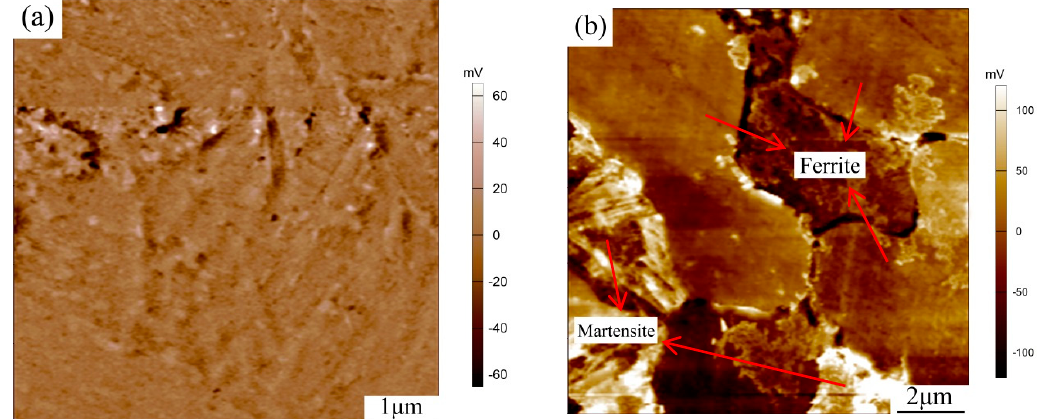
Figure 7. Volta potential images of ( a ) bimodal ferrite steel and ( b ) dual-phase steel.